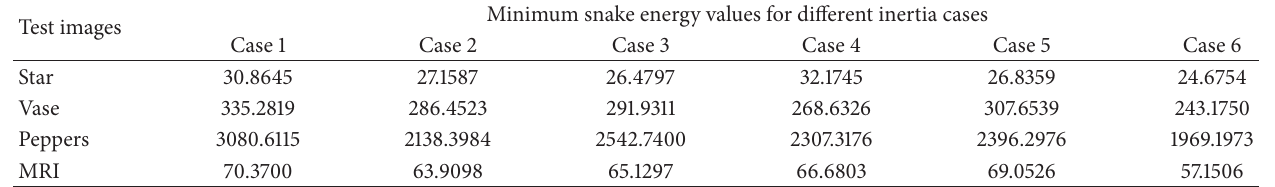
Table 3: Minimum snake energy values obtained by “proposed multiswarm PSO” method for different cases of